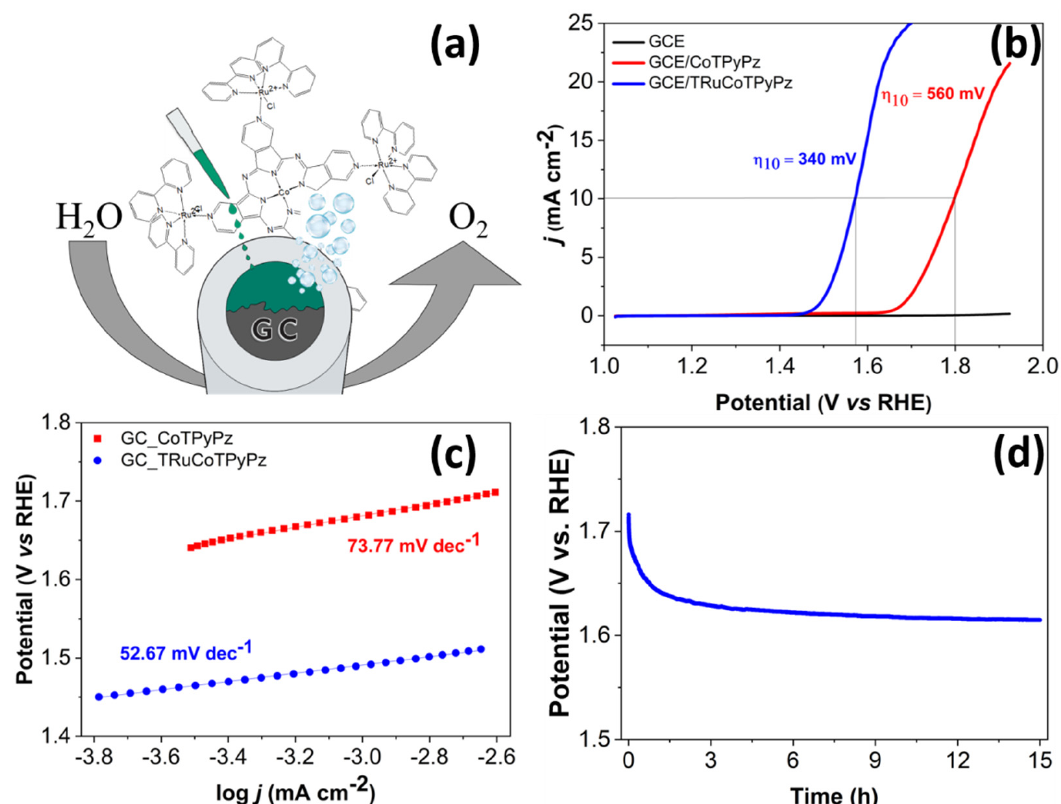
Figure 8. ( a ) General scheme of the molecular film onto GCE for O 2 evolution. ( b ) LSV polarization curves at v = 5 mV s − 1 in 1.0 mol L − 1 KOH solution and corresponding (same color) Tafel plots ( c ) for CoTPyPz/GCE and TRuCoTPyPz/GCE. ( d ) Potential as a function of time registered during electrolysis (OER) using GC electrodes modified with TRuCoTPyPz.